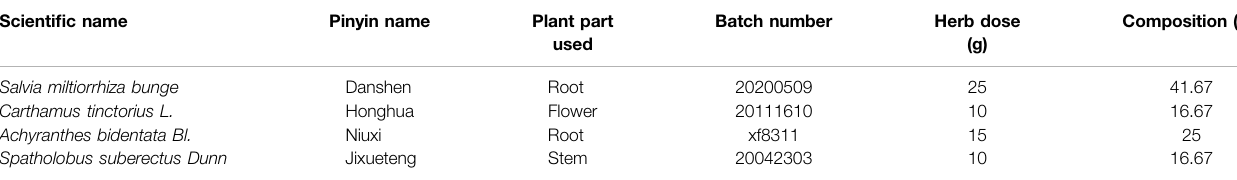
TABLE 1 | The herbal composition and proportion of TLYS